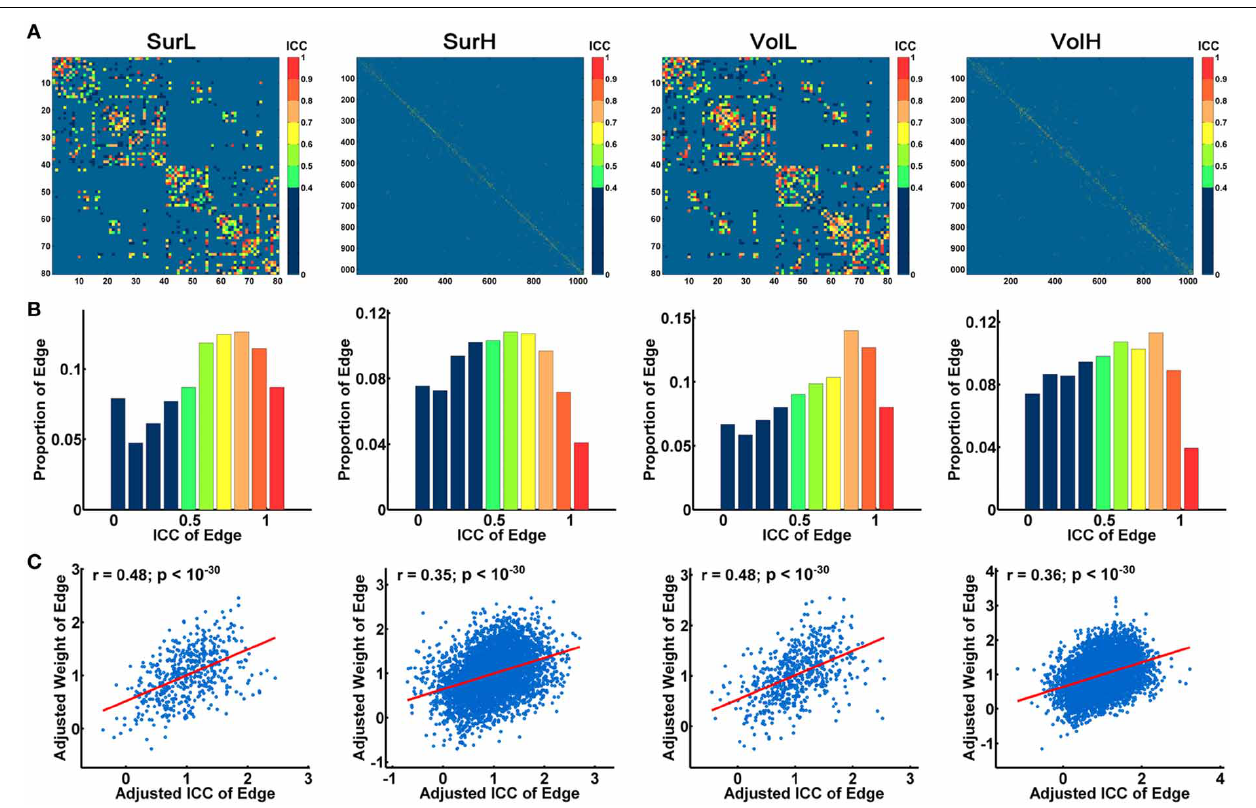
FIGURE 8 | The TRT reliability of structural connections. (A) Spatial distribution of the edge ICCs of WM networks constructed from different procedures. (B) Normalized histograms of edge ICCs from 0 to 1, with an interval of 0.1. (C) The correlation between connection